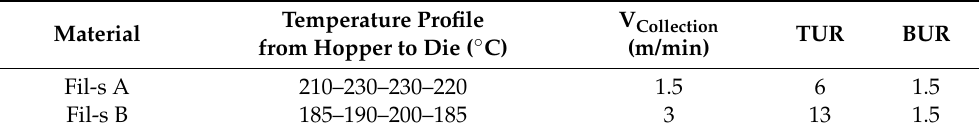
Table 2. Operative conditions for film blowing extrusion of the different Fil-s